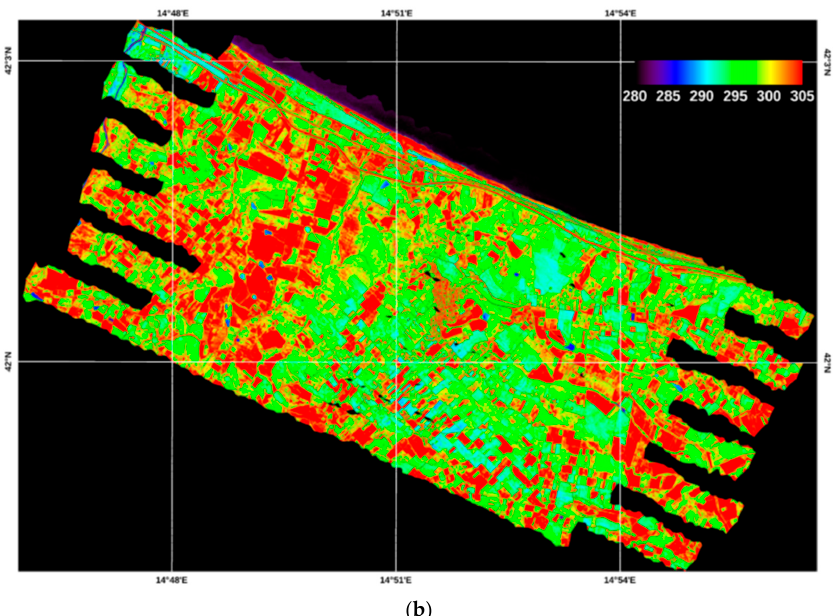
Figure 6. Ground temperatures obtained from the TASI images in the morning ( a ) and during maximum solar load ( b ).